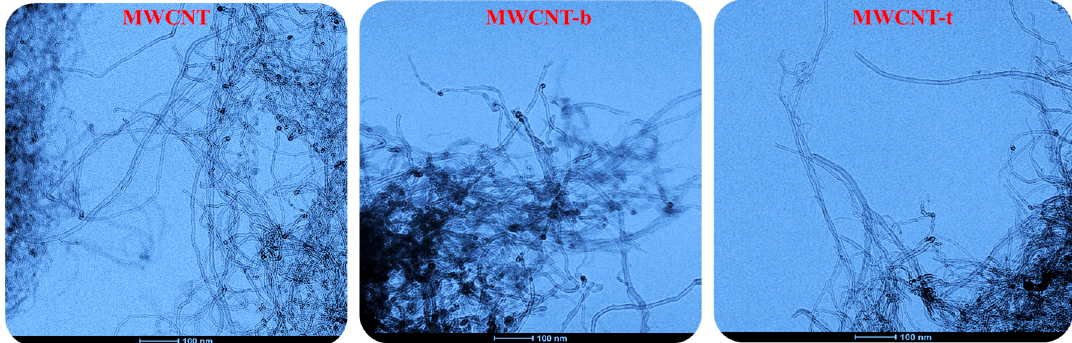
Figure 7. HRTEM pictures of MWCNT, MWCNT-b, and MWCNT-t